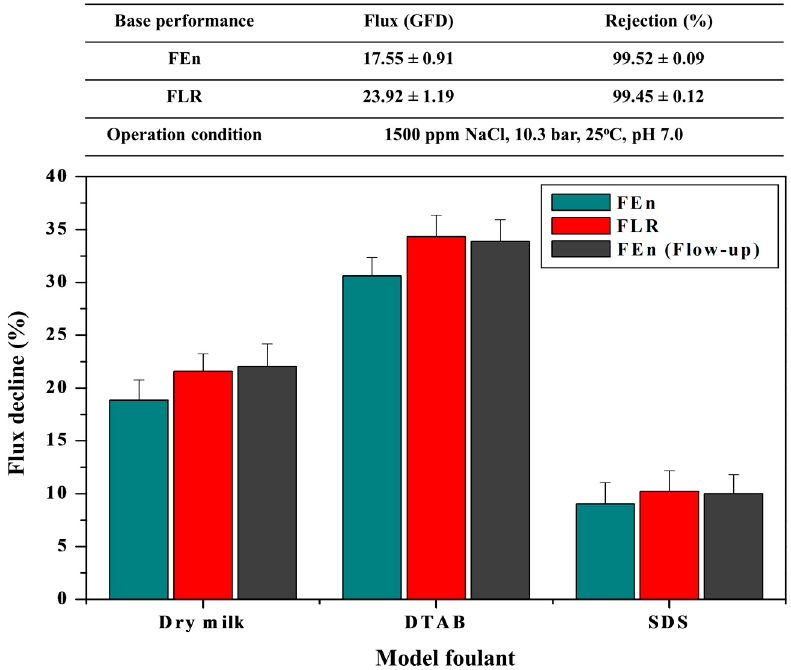
Figure 3. Flux decline comparison between the FEn and FLR adopting model foulants (Operation SDS, respectively). Table 2. Details of the reverse osmosis membranes used in the experiments.